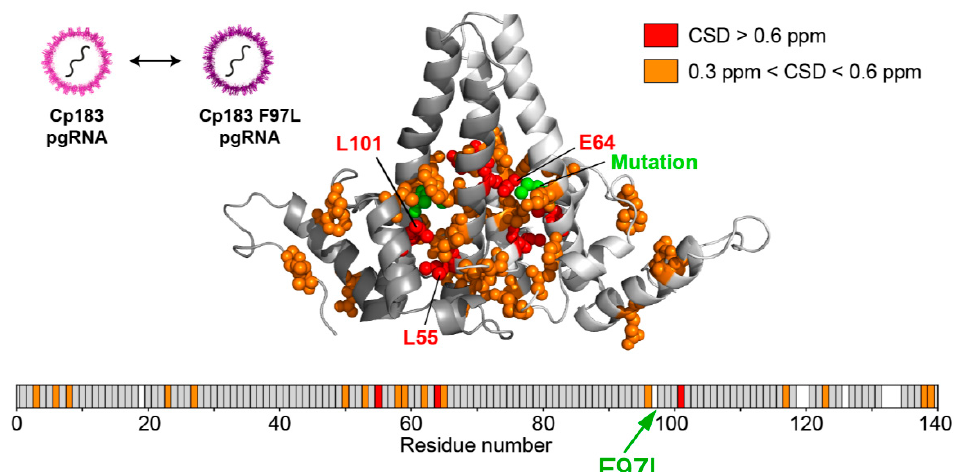
Figure 8. Solid-state NMR can detect conformational alterations with high resolution at near-native conditions. Once all resonances are assigned in a reference structure other, similar samples can be compared against the reference. In the example recombinant pgRNA loaded CLPs from wild-type Cp183 and its variant F97L were compared; in cell culture this mutation relaxes the restriction on envelopment of nucleocapsid carrying immature genomes (adapted from Lecoq et al.). Residues whose conformational environment changes by the mutation experience chemical shift differences (CSDs) compared to the reference; larger differences indicate larger alterations. The linear representation at the bottom assigns such residues to the primary sequence, the model above to the structure of the Cp dimer. Note that numerous residues not only in immediate vicinity to the mutation are affected. The impact of bound ligands on the structure can similarly be determined, even in irregularly assembled multimers. Figure courtesy of Lauriane Lecoq and Anja Böckmann.